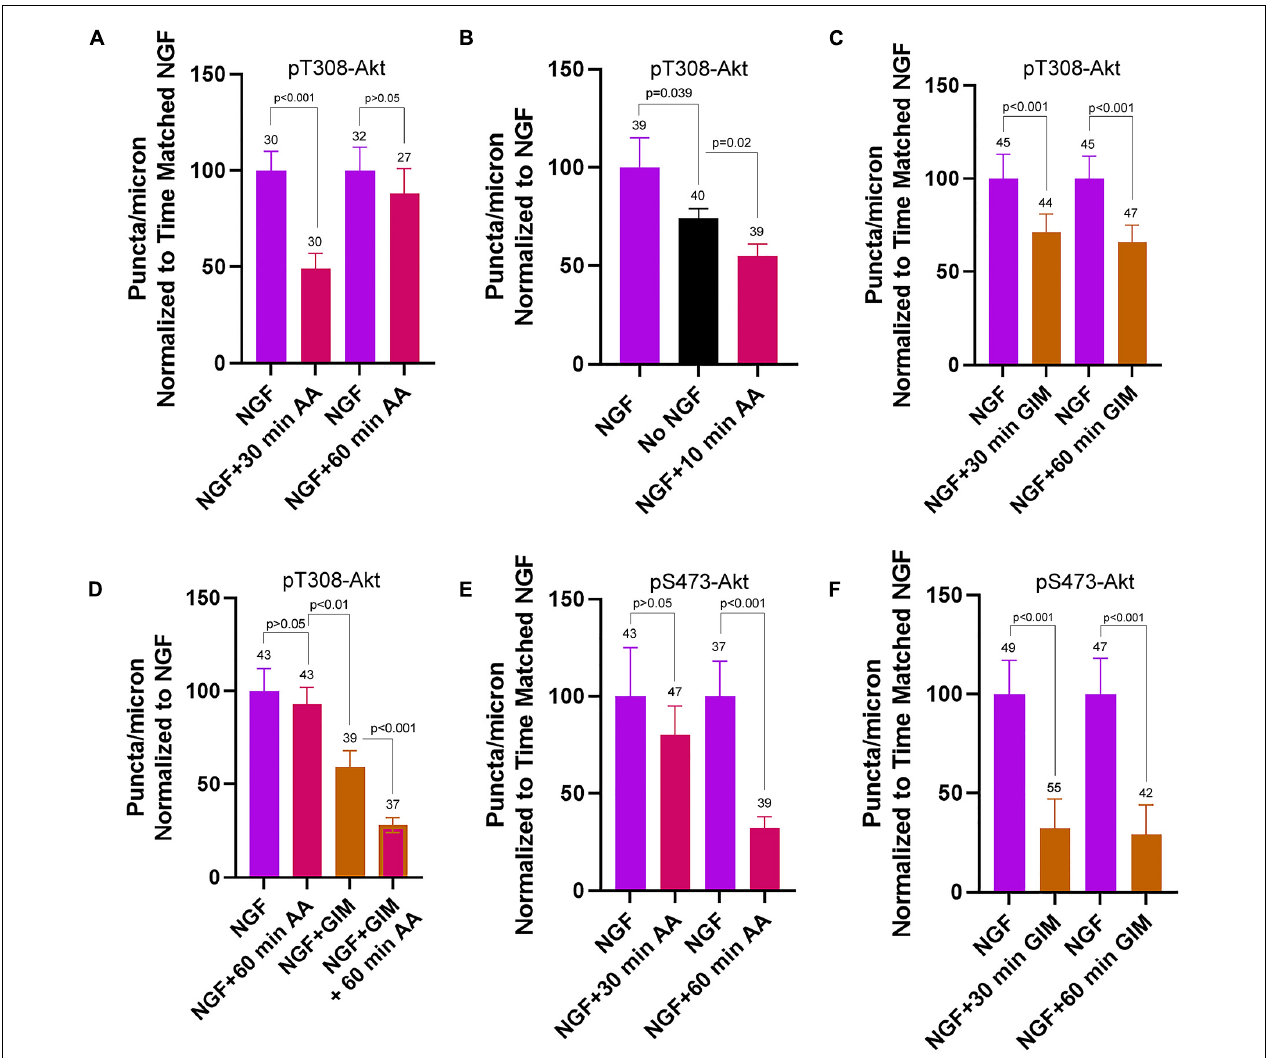
FIGURE 5 | Contributions of oxidative phosphorylation and glycolysis to steady state NGF (24 h treatment) driven pT308-Akt and pS473-Akt phosphorylation. (A) Effects of a 30 and 60 min treatment with antimycin-A on the density of pT308-Akt puncta in axons. A 30 min treatment decreased the density that, however, restored to the time matched control levels by 60 min. (B) A 10 min treatment with AA decreased the density of pT308-Akt punctato a similar extent as a 30 min treatment (A) , and below those present in no NGF conditions. (C) GIM treatment for 30 and 60 min similarly decreased the density of pT308-Aktpuncta. (D) The restoration of the density of pT308-Akt punctato baseline after a 60 min treatment with AA is prevented by cotreatment with GIM. (E) Treatment with AA decreases the density of pS473-Akt puncta after a 60 min treatment but not a 30 min treatment. (F) Both 30 and 60 min treatments with GIM similarly decrease the density of pS473-Akt